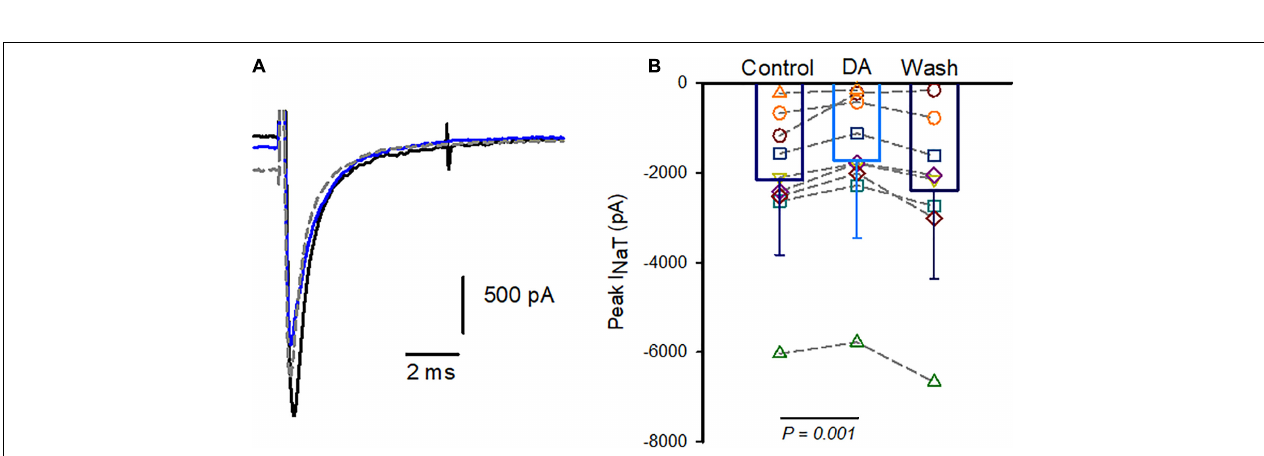
FIGURE 2 | Dopamine reversibly reduces I NaT in isolated calyx terminals. (A) Whole cell currents in an isolated calyx in response to a voltage step from –90 to –40 mV following a prepulse to –130 mV. Control Na + current (black), current in 100 µ M dopamine (blue) and current during washout (gray dashed line) are shown. P22 calyx, female. (B) Pooled data show peak currents in individual cells and bars indicate mean I NaT in control, in response to 100 µ M dopamine (DA) and during washes. Peak currents were measured at voltage steps to –40 mV and averaged –2,151 ± 1,685 pA in control; and –1,732 ± 1,718 pA (mean ± SD, n = 9 cells) in dopamine. Recovery during wash was measured in 8 cells since 1 cell was lost prior to wash (P21-27 calyces, 5 K + -filled cells and 4 Cs + -filled cells).